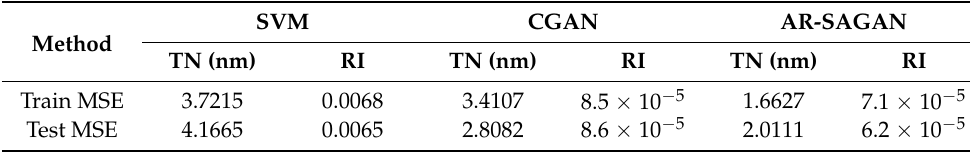
Table 3. Predicted quality under different